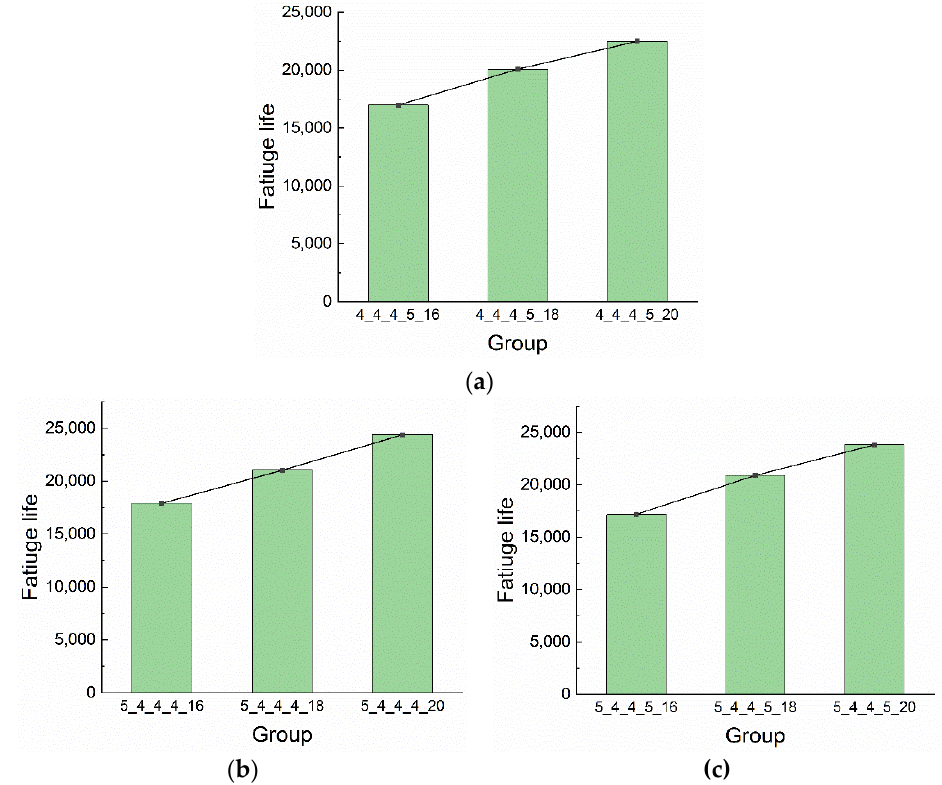
Figure 21. The fatigue lives of riveted lap joints with different rivet pitches: ( a ) groups 4_4_4_5_x ; ( b ) groups 5_4_4_4_x; ( c ) groups 5_4_4_5_x.